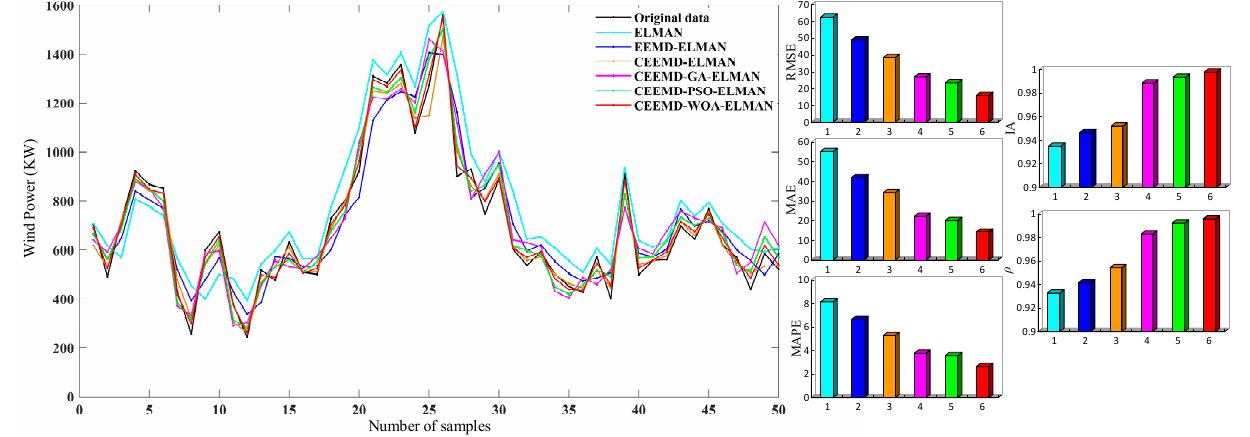
Figure 11. Wind power prediction results of six models of Number Two wind turbine.